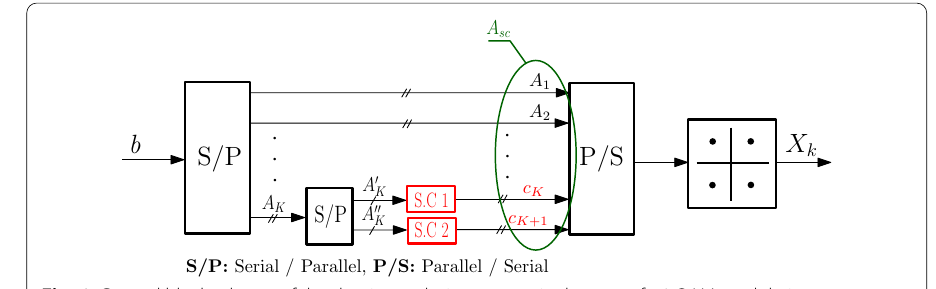
Fig. 6 General block scheme of the shaping technique, K Table 3 Proposed shaping code ( k s Data bits A ′ K / A ′′